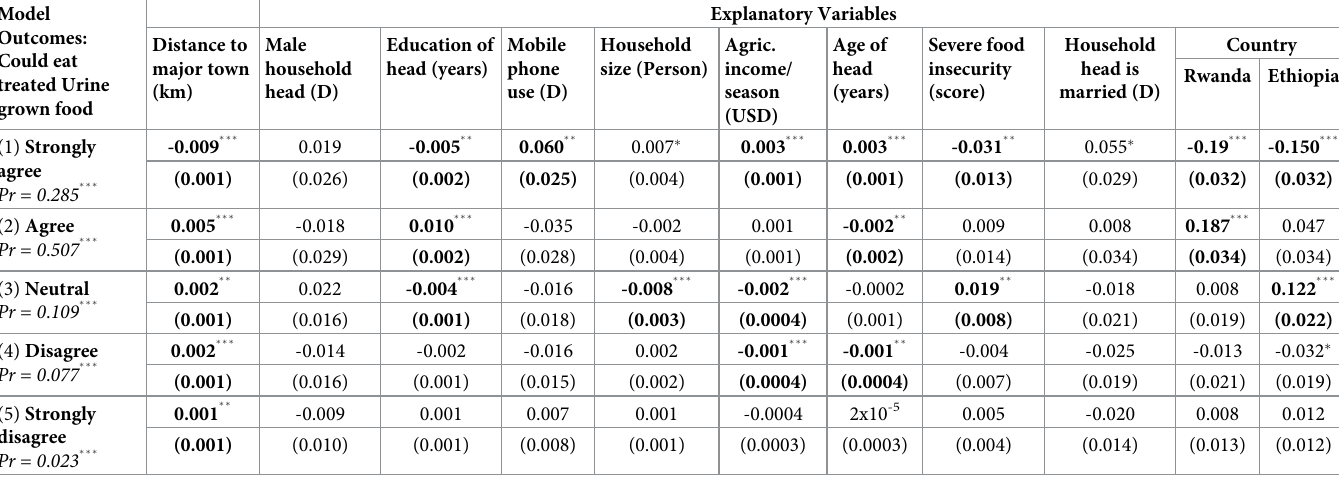
Table 9. Marginal effects after generalized ordered logit on eating foods grown on treated urine. Model Outcomes: